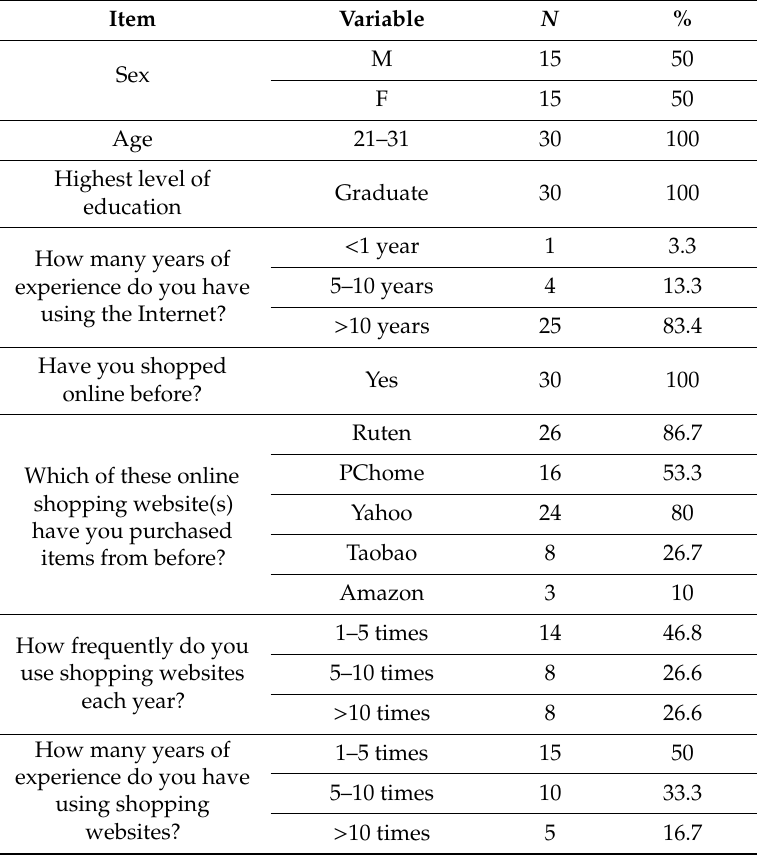
Table 2. Demographic statistics.